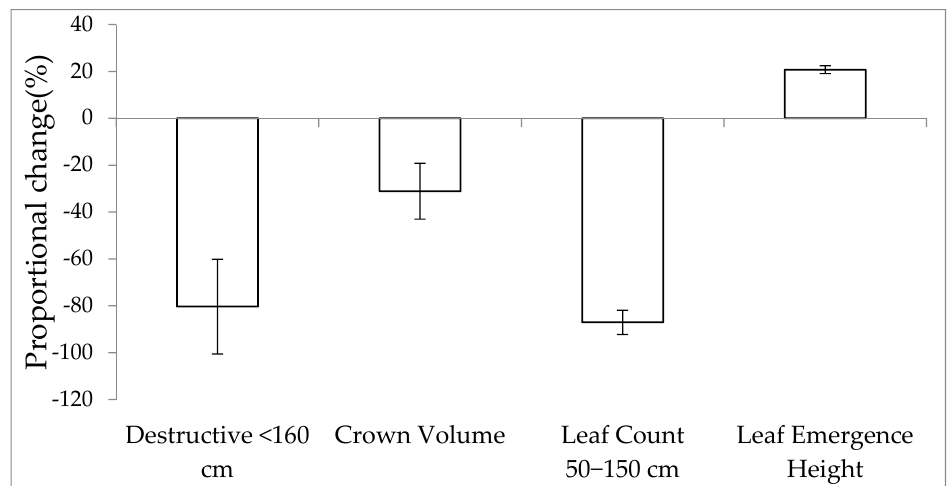
Figure A3. Proportional change (%) of Leucaena leucocephala biomass for four assessment methodologies used to detect biomass removal following cattle browsing.